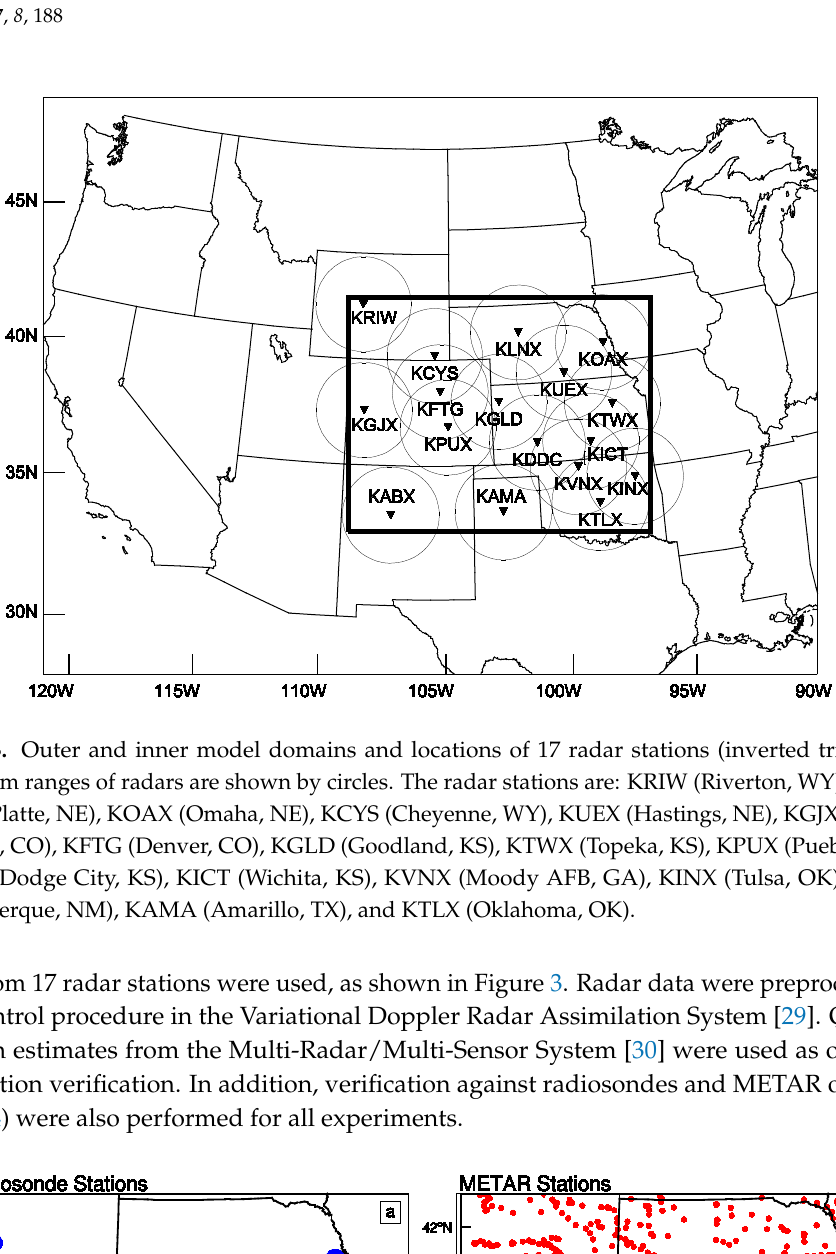
Figure 4. ( a ) The locations of 10 radiosondes (blue dots); and ( b ) 1927 METAR (red dots) stations over the inner region of domain.